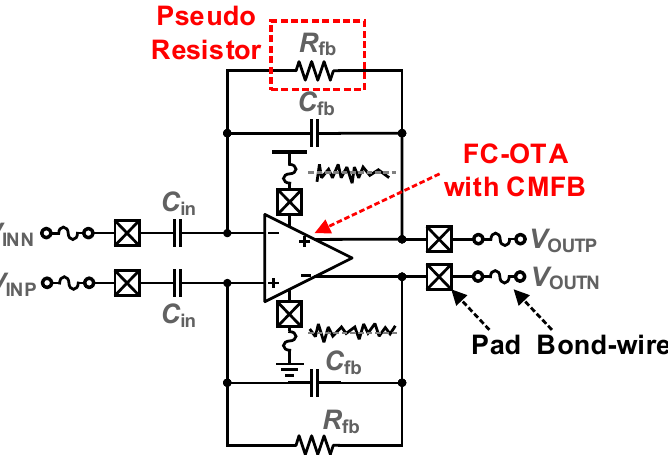
Figure 4. A test AC-coupled neural recording amplifier for the comparison of the conventional DDA-based CMFB and proposed CMFB.